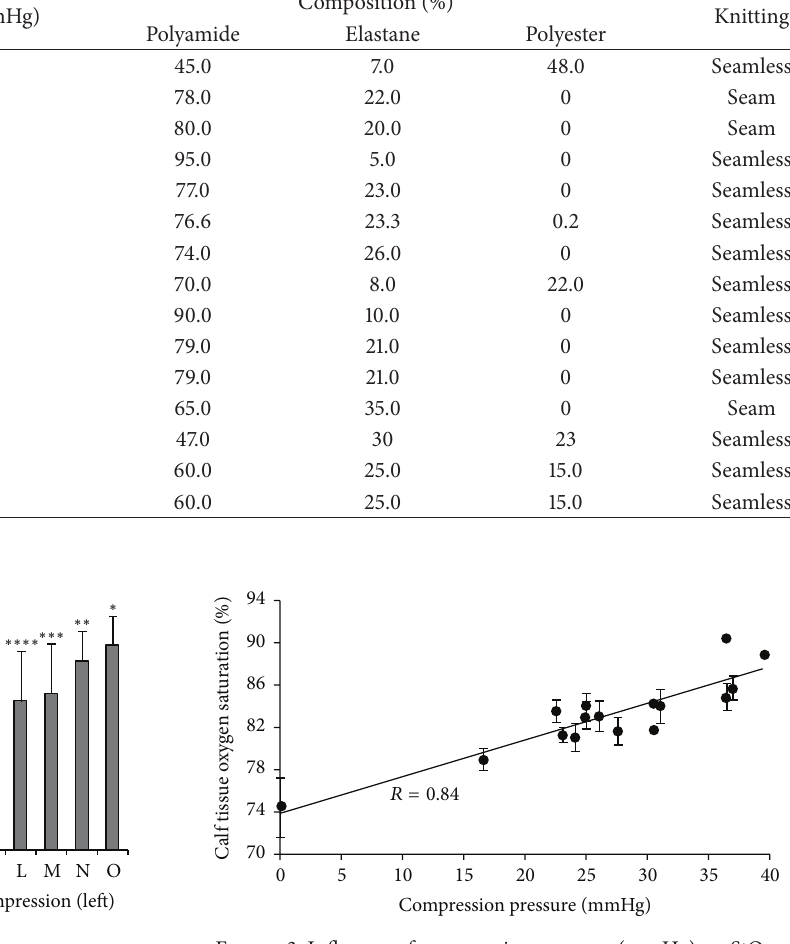
Figure 3: Influence of compression pressure (mmHg) on StO 2